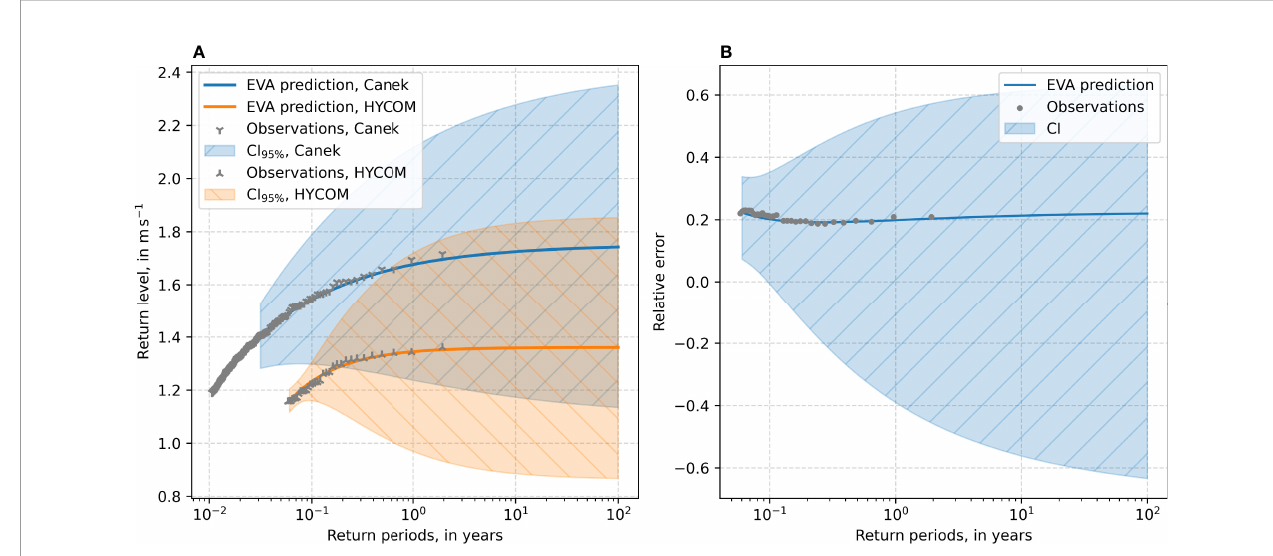
FIGURE 3 | Results of the simpli fi ed EVA for the adjusted numerical and empirical data. The adjusted numerical data are limited to the temporal range of the empirical data. (A) Return level plot. (B) Relative error of estimated return